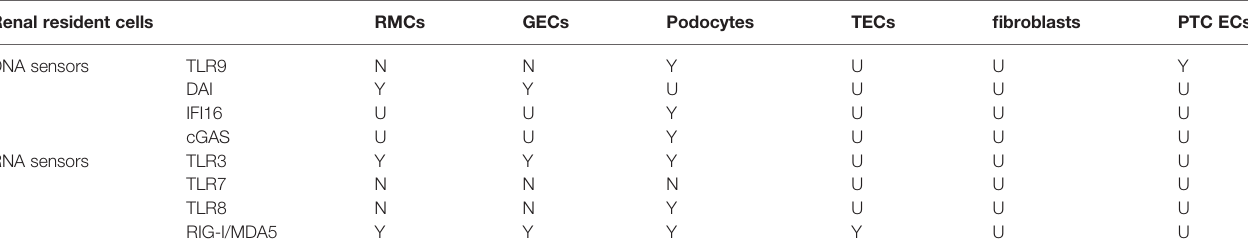
TABLE 2 | Distribution and expression of DNA/RNA sensors in renal resident cells. Renal resident cells DNA sensors